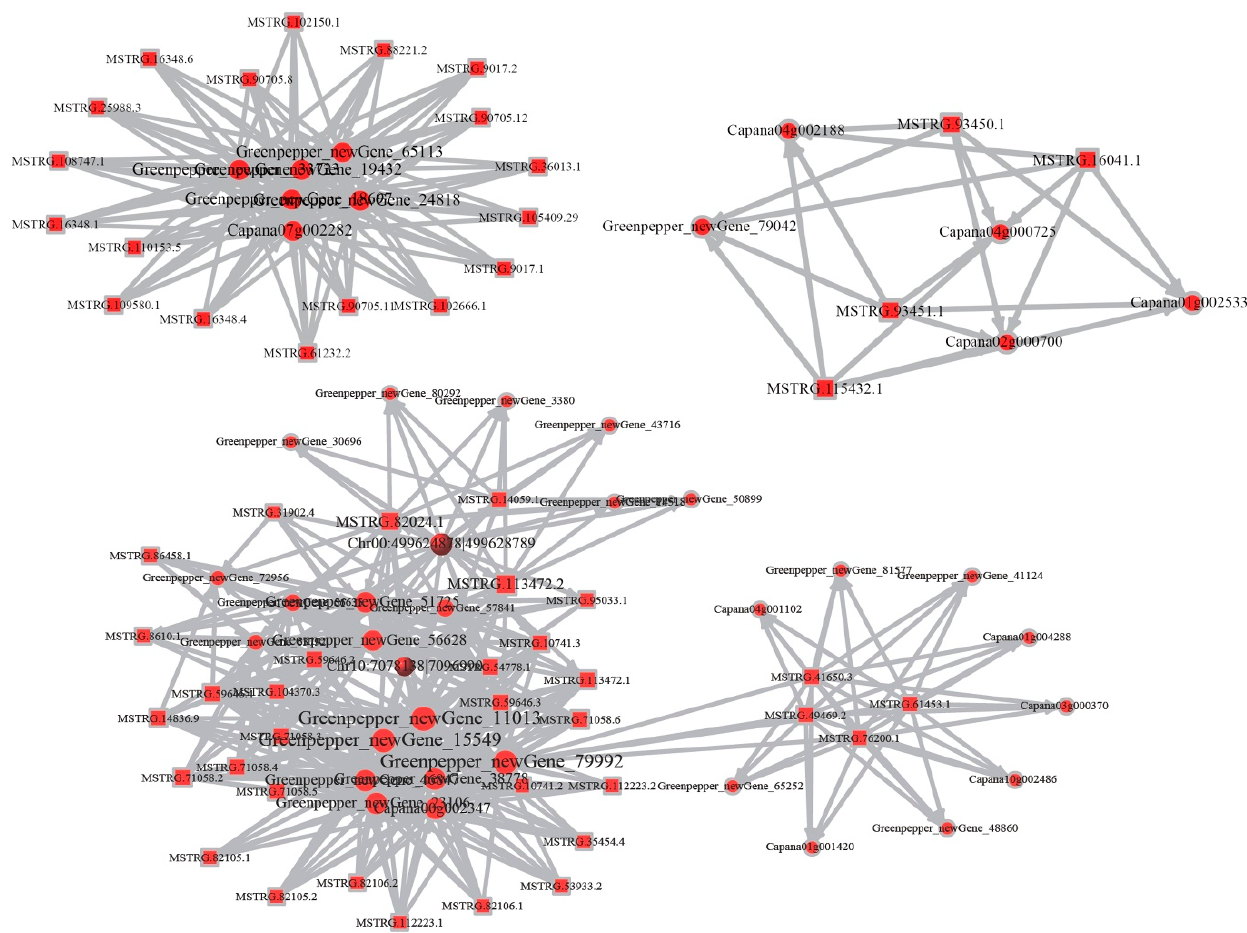
Figure 5. The ceRNA networks of mRNAs, lncRNAs, and circRNAs were parsed, and ceRNA relationship pairs were obtained, including 162 mRNAs, 81 lncRNAs, and 4 circRNAs.